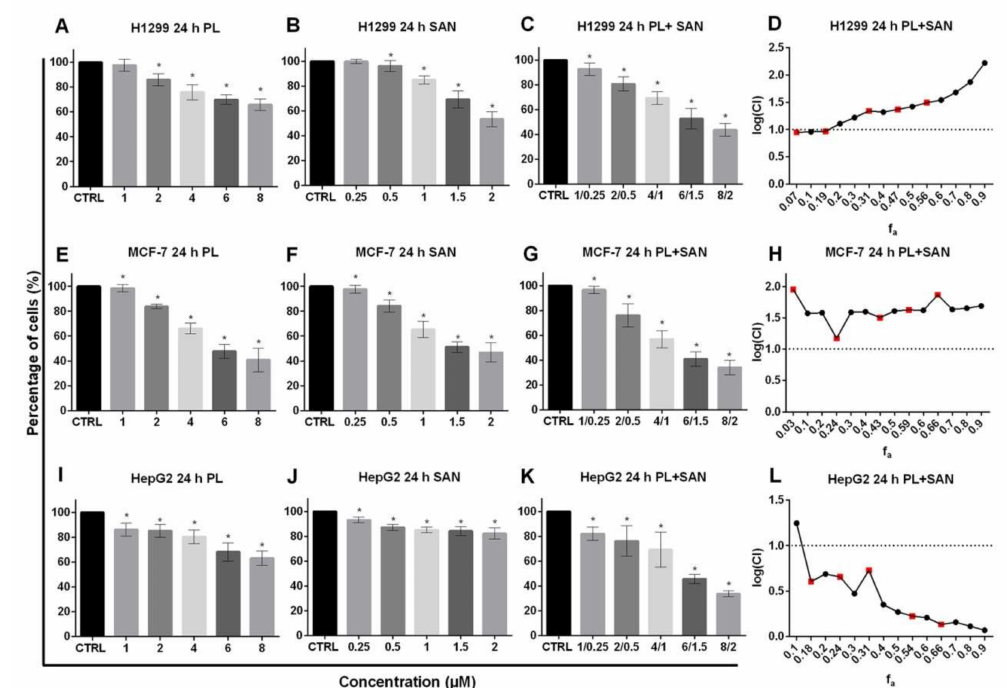
Figure 3. The cytotoxic e ff ects of piperlongumine (PL) and sanguinarine (SAN) individually and in combined treatment on the cell viability of H1299, MCF-7 and HepG2. The analysis was based on the results obtained from the MTT assay. Cells were treated for 24 h with PL at concentrations 1–8 µ M ( A , E , I ); SAN at doses of 0.25, 0.5, 1, 1.5 and 2 µ M ( B , F , J ) and their combination in ratio 4:1 ( C , G , K ). Data represent the mean values ± SD obtained from 6 independent replicates ( n = 6). Statistically significant di ff erences with respect to untreated cells, where survival was estimated as 100%, were marked as * ( p < 0.05; Wilcoxon test). The combination index plot for the PL and SAN cotreatment in H1299 cells ( D ), MCF-7 cells ( H ) and HepG2 ( L ) in the range of f a from 0.1 to 0.9. CI < 1—synergism, CI = 1—additive e ff ect and CI > 1—antagonism. For real measuring points, the values have been marked in